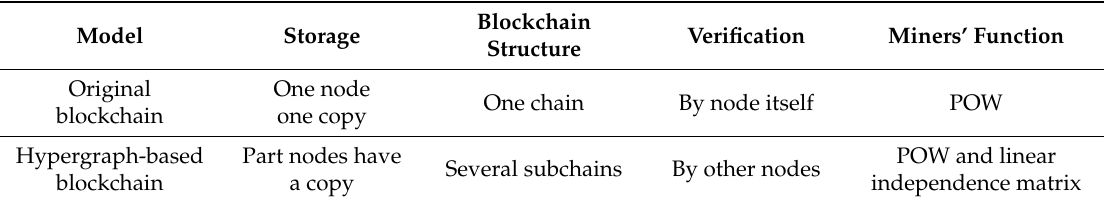
Table 1. Comparison of blockchain